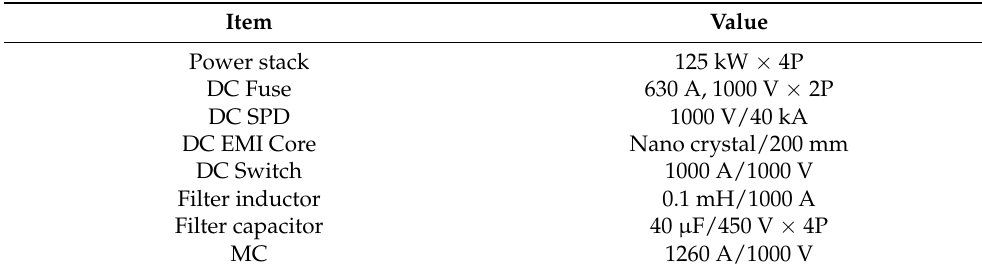
Table 7. Rating of the major parts for the 500 kW inverter panel.